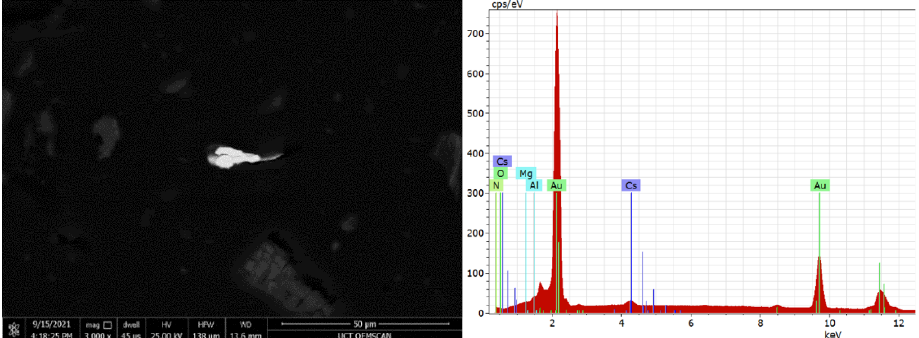
Figure 2. SEM-EDS image of gold particle in Sample 2.